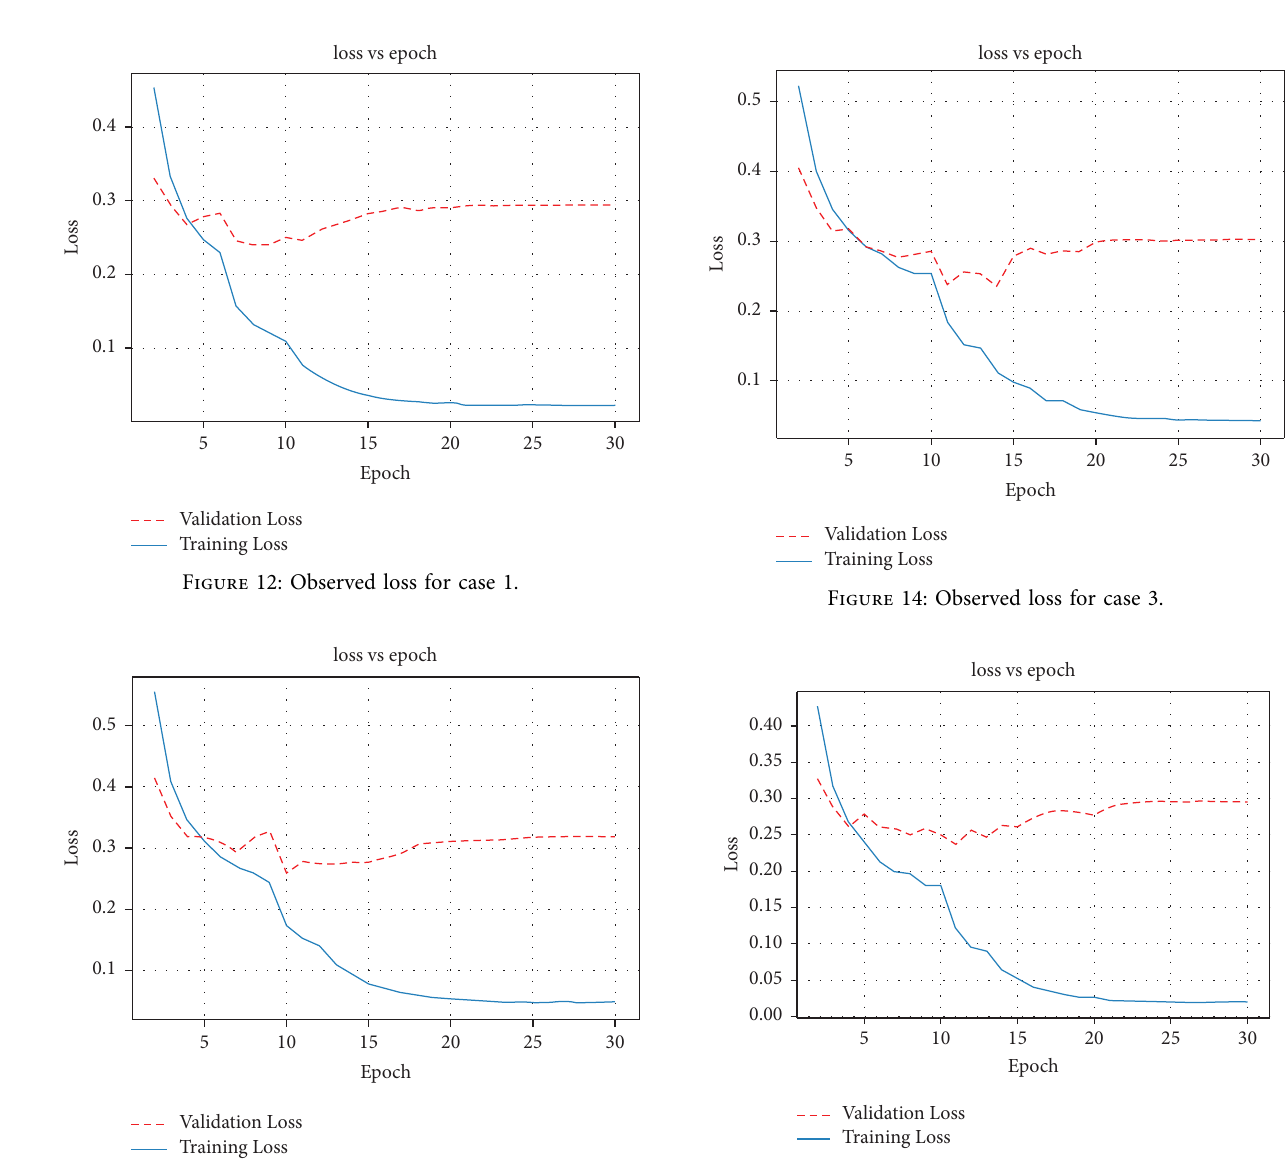
Figure 13: Observed loss for case 2.